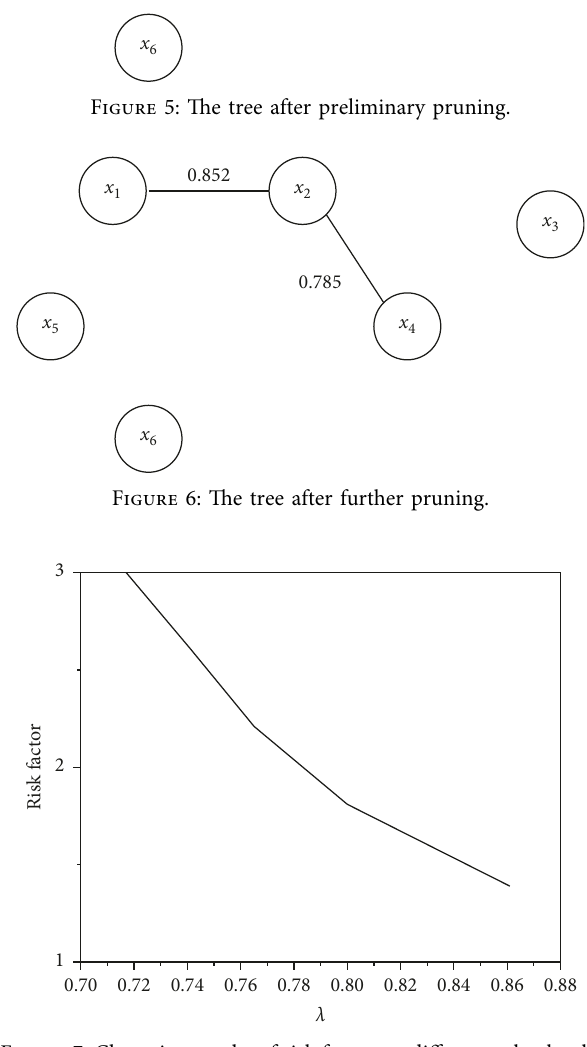
Figure 7: Clustering results of risk factors at different value levels.